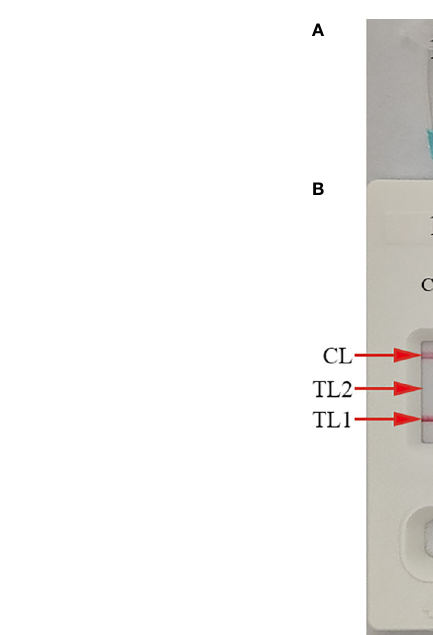
FIGURE 3 mLAMP product con fi rmation and veri fi cation The mLAMP products were simultaneously identi fi ed using (A) malachite green and (B) the AuNPs- LFB. Tube/AuNPs-LFB 1 shows a positive C . trachomatis result. Tube/AuNPs-LFB 2 shows a positive N. gonorrhoeae result. Tube/AuNPs-LFB 3 shows a positive C . trachomatis and N. gonorrhoeae result. Tube/AuNPs-LFB 4 shows negative control (DW). Key: CL, control line; TL1, test line one; TL2, test line two; CT, C . trachomatis ; NG, N. gonorrhoeae